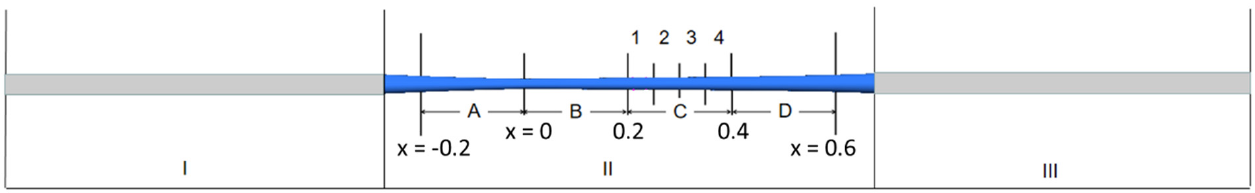
Figure 2. Coordinate system for Laval nozzle.